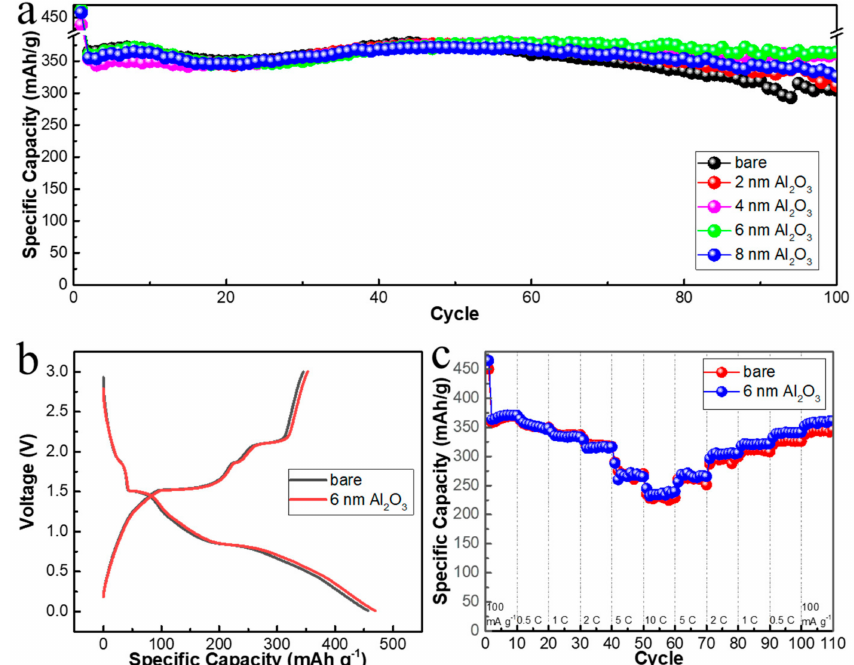
Figure 3. ( a ) The cycling performance of Cu 2 S@NG electrodes with di ff erent ALD coating thicknesses at 100 mA g − 1 in the potential range of 0.01–3.0 V. ( b ) Comparison of the 1st cycle discharge–charge